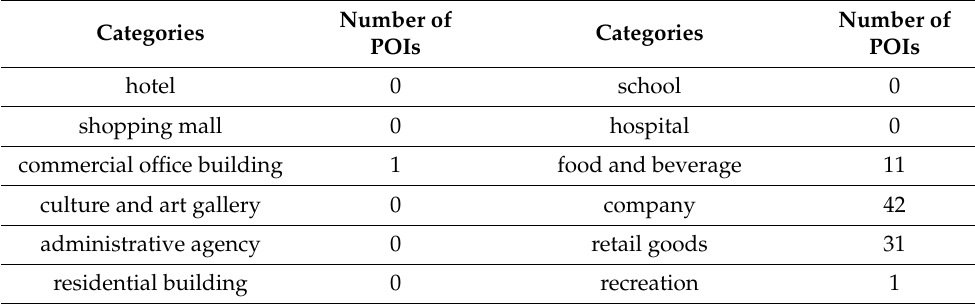
Table 2. The number of 12 categories of POIs inside one